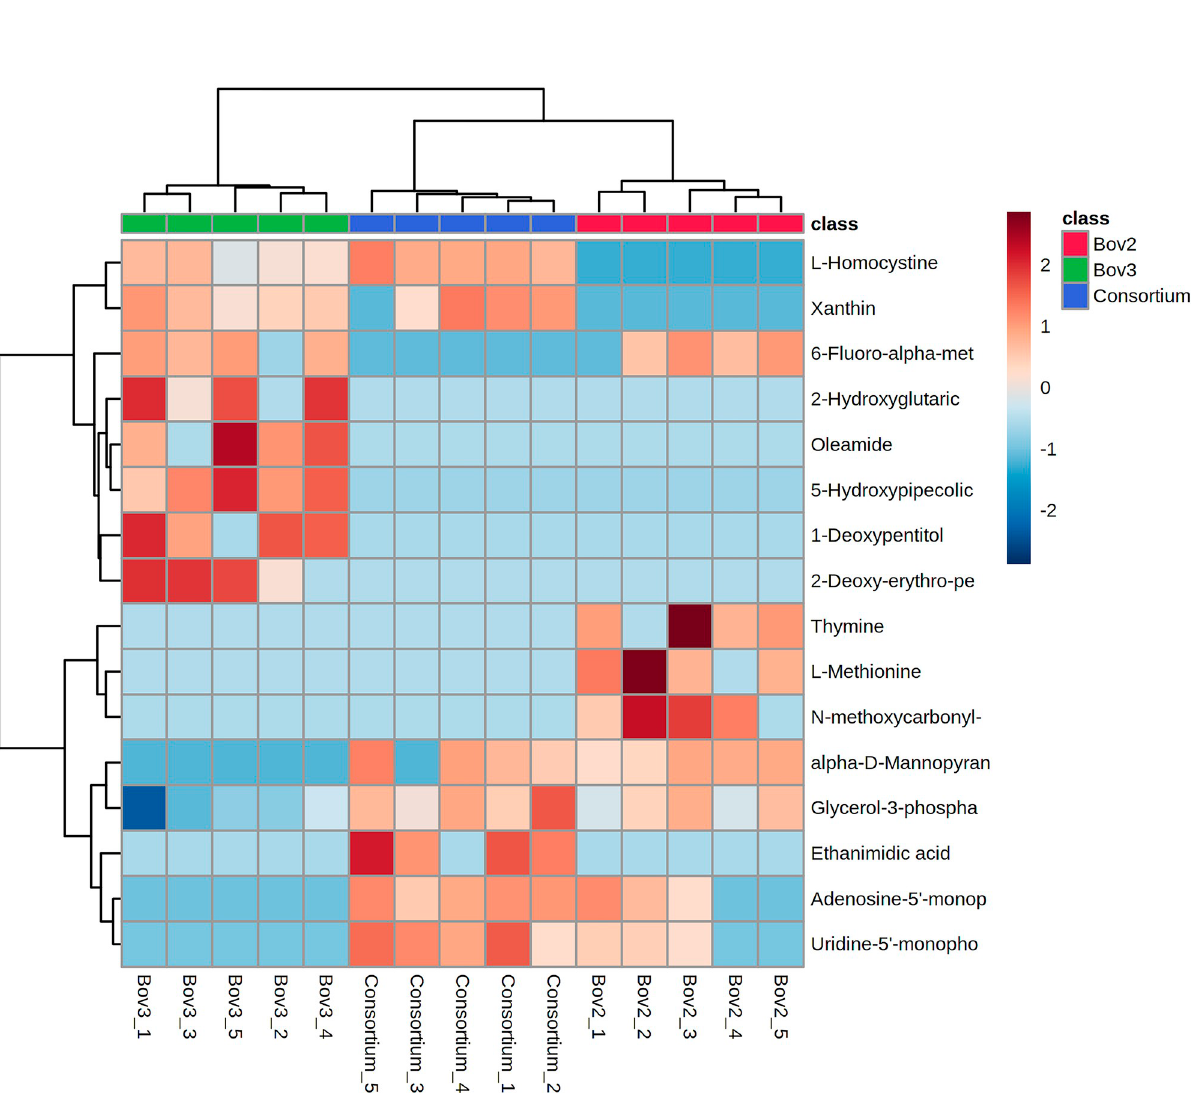
Fig 2. HEATMAP of the 16 biomarkers identified in Bov 2, Bov 3 and consortium.